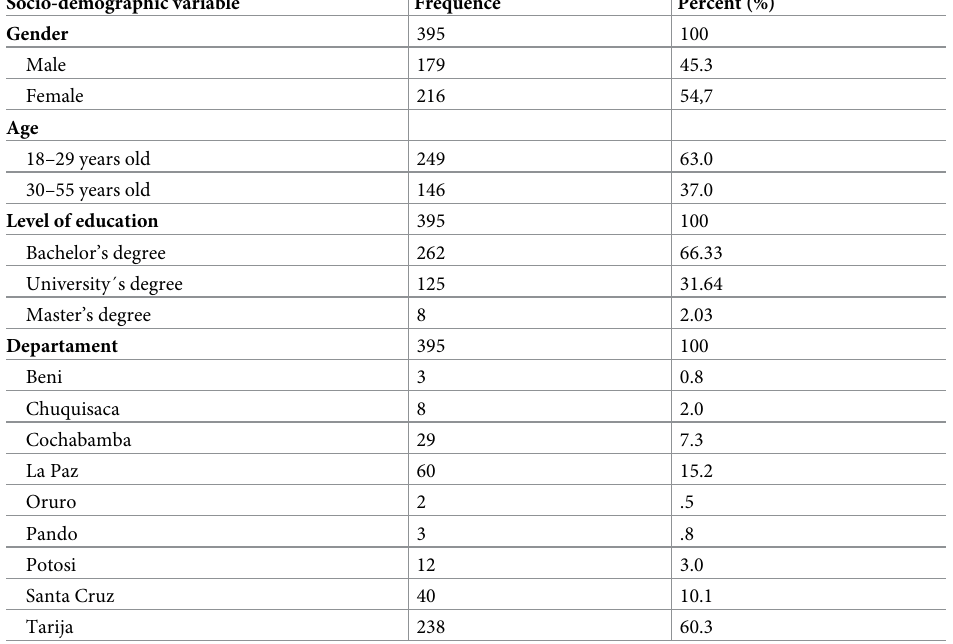
Table 1. Descriptive